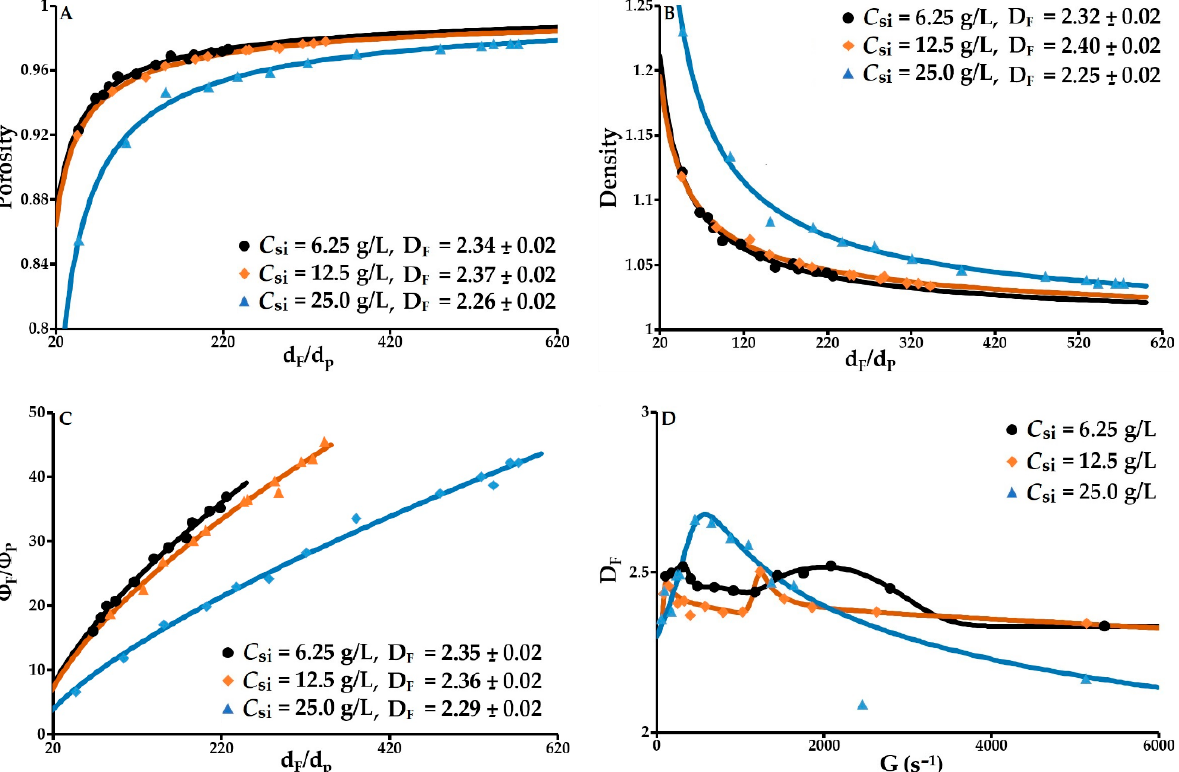
Figure 6. Textural parameters of flocs determined through laser diffractometry. ( A ) Porosity vs. d F /d P ; ( B ) Density vs. d F /d P ; ( C ) Relative volume fraction of flocs vs. d F /d P ; ( D ): Fractal dimension vs. velocity gradient.